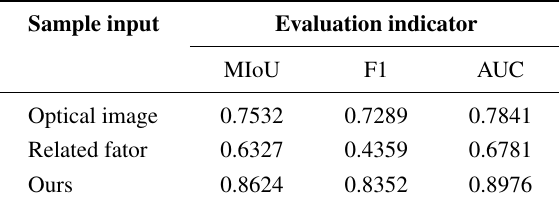
Table 3. Results of landslide-related factor validation experiments.